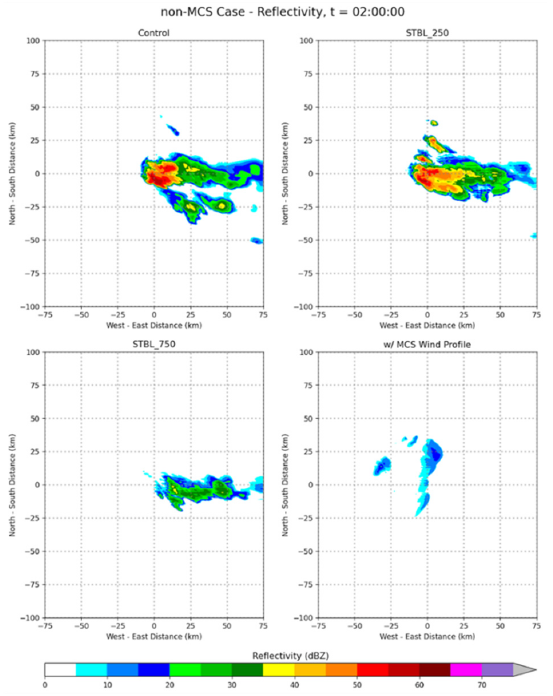
Figure 18. As in Figure 17, but for the 8 August 2016 non-MCS